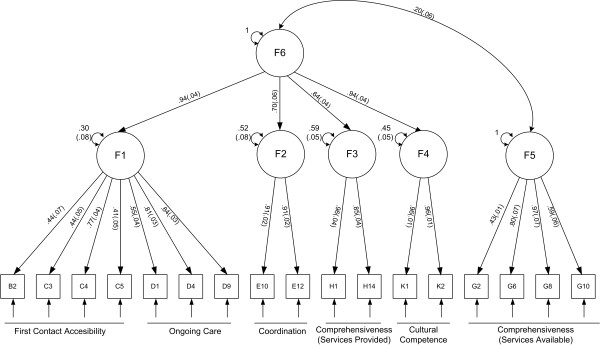
Factor structure of the PCAT-CE, very short version (confirmatory factor analysis). Squares are the items; circles are the resulting factors; unidirectional arrows are factor loadings; and bidirectional arrows are either correlations between factors or residual variances. Standard errors are shown in parenthesis.